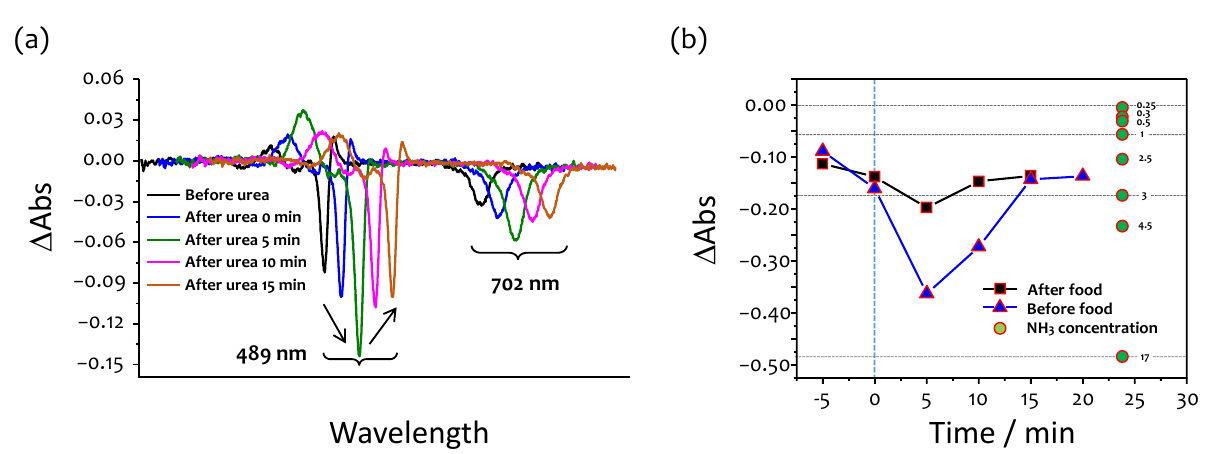
Figure 8. ( a ) Difference absorption spectra measured before and at different intervals after the consumption of 5 mL of a 1 mM aqueous urea solution. ( b ) Dynamic changes in absorbance measured at 489 nm after drinking the 1 mM of urea solution: the black (squares) and blue (triangles) lines represent concentrations measured after food consumption and on an empty stomach (before food consumption), respectively; green circles map the concentrations of ammonia derived from the calibration curve (Figure 4c). The spectra in Figure 8a are shifted horizontally for illustration purposes and convenience in reading the figure.